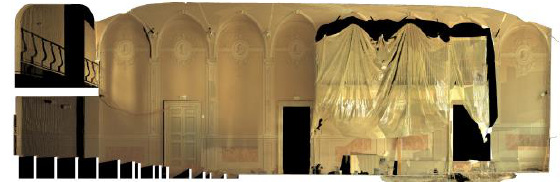
Figure 8. Longitudinal section of the vault, achieved by the laser scanner survey